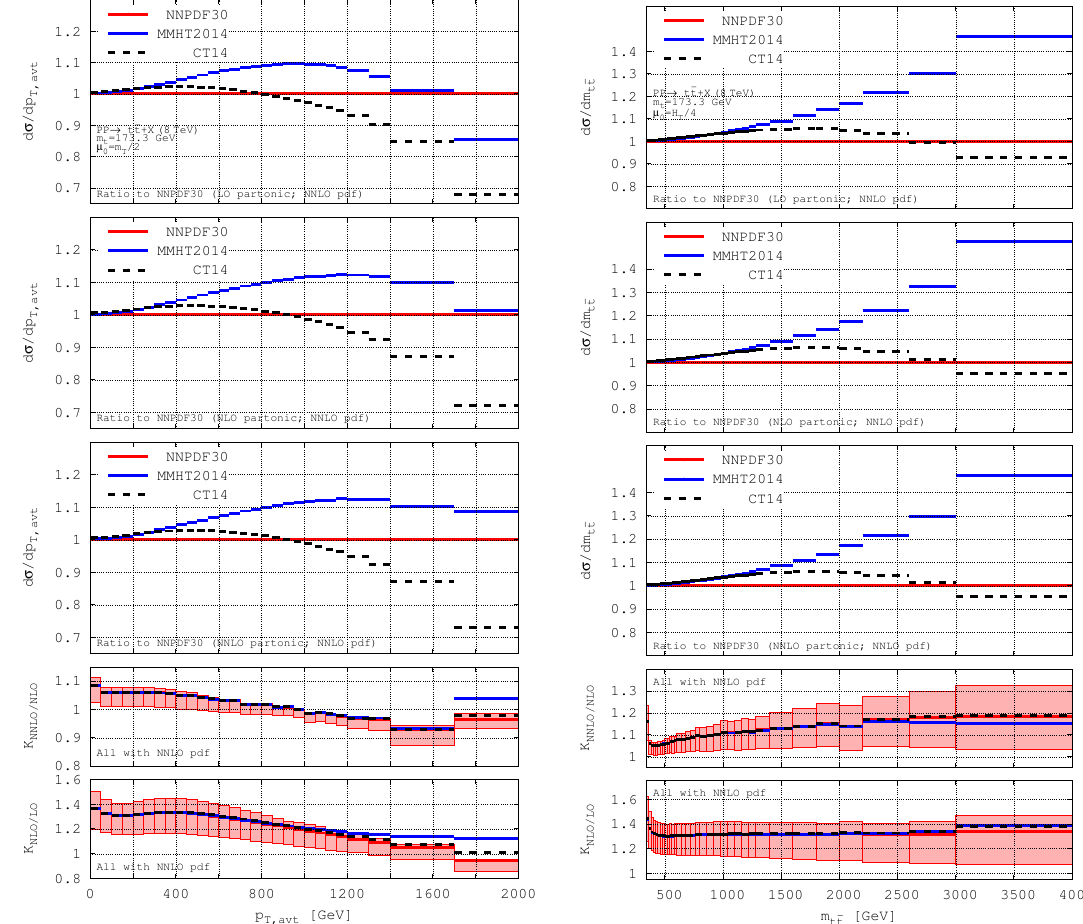
Figure 10 . Absolute p (left) and m (right) distributions. All curves are computed with NNLO T;t= (cid:22) t t (cid:22) t pdf; partonic cross-sections are at LO, NLO or NNLO. Error bands are from scale variation only. sections are all convoluted with the same NNLO pdf). Based on the conclusions above, the K-factors for each scale should be pdf independent. We notice that all K-factors are very similar to the ones in (cid:12)gures 5, 6 and most importantly, the K-factors for the \best" scale choices eq. (3.9) are consistently the smallest ones, and the ones closest to unity, among all dynamic scales considered by